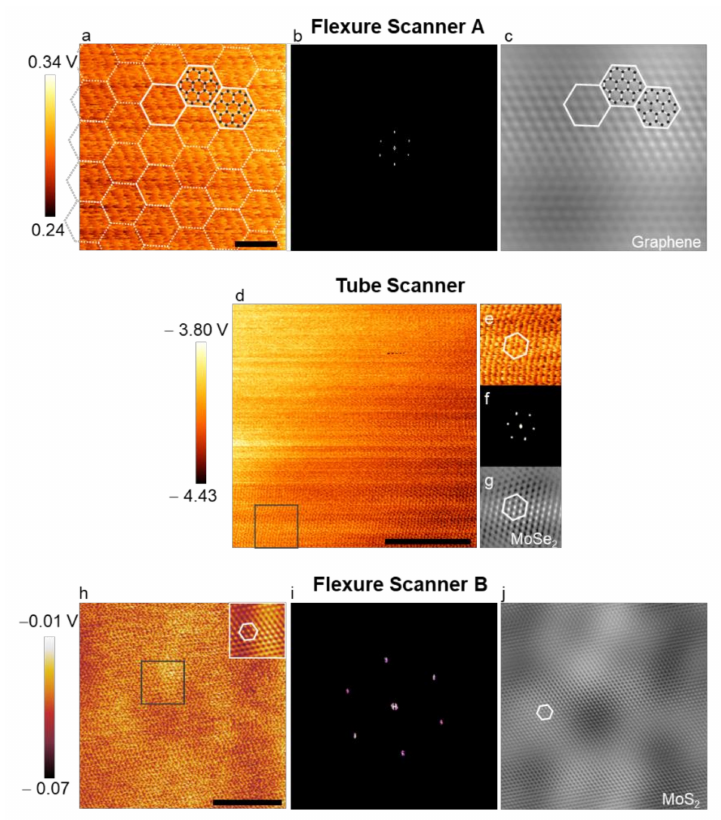
Figure 8. Demonstration of LFM lattice images obtained by applying our protocol to several com- mercial AFMs. ( a ) LFM raw (unflatten and unfiltered; color range adjusted) image of graphene acquired at a scan size of 50 Å and a scan rate of 22.45 Hz using an XE-100 AFM system. The scale bar corresponds to 1 nm; ( b ) filtered FFT image of the raw data shown in ( a ); ( c ) resulting inverse FFT image. The black dots in ( a ) and ( c ) represent carbon atoms arranged around hollow sites; ( d ) LFM raw image of MoSe 2 collected at a scan size of 300 Å and a scan rate of 12.90 Hz using a CP-II AFM system. The scale bar corresponds to 10 nm; ( e ) the enlarged view of the squared area in ( d ); ( f ) filtered FFT image of ( e ); ( g ) the resulting inverse FFT image; ( h – j ) LFM image of MoS 2 obtained at a nominal scan size of 250 Å and a scan rate of 17.0 Hz using an NX10 AFM system, the filtered FFT, and the resulting inverse FFT. The inset in ( h ) is an inverse FFT image of the squared area. The scale bar in ( h ) corresponds to 10 nm. All white hexagons are for visual